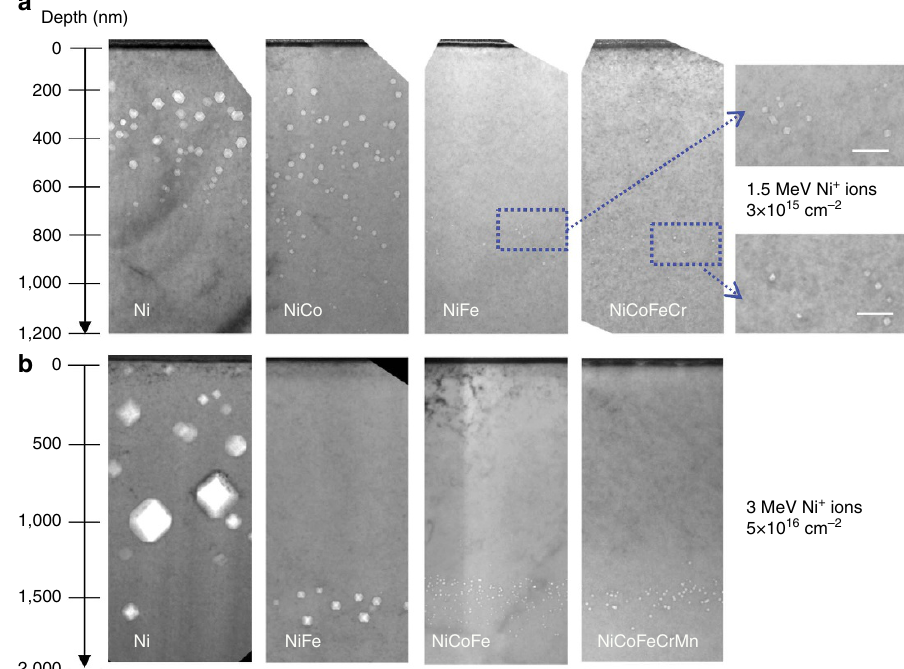
Figure 1 | Irradiation-induced void distribution. ( a ) Cross-sectional TEM images of nickel, NiCo, NiFe and NiCoFeCr irradiated with 1.5MeV Ni þ ions to 3 (cid:2) 10 15 cm (cid:3) 2 at 773K, scale bars in the zoomed images are 50nm. ( b ) Cross-sectional TEM images of nickel, NiFe, NiCoFe and NiCoFeCrMn irradiated with 3MeV Ni þ ions to 5 (cid:2) 10 16 cm (cid:3) 2 at 773K. The ions enter the specimen from the top of the